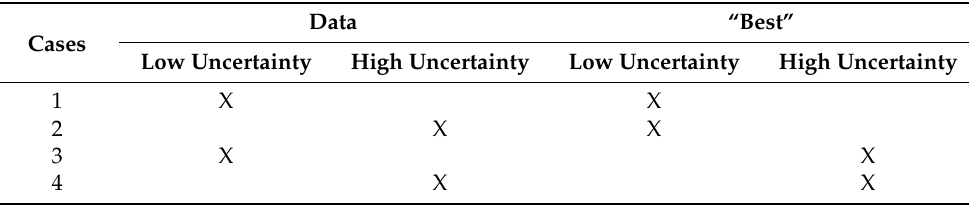
Table 5. Proposed trial matrix to separate input uncertainty effect on algorithm’s evaluation.